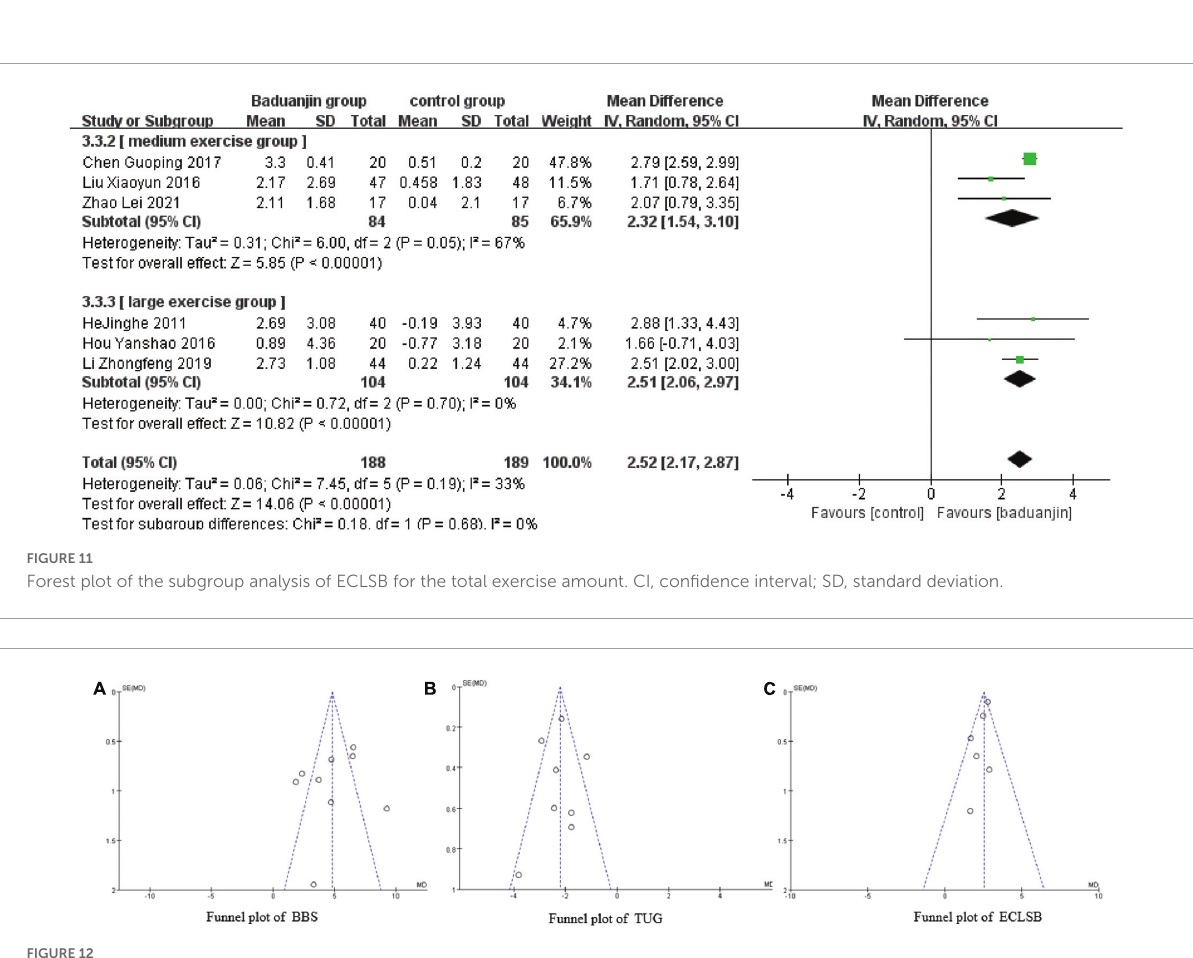
FIGURE12 Funnel plots of BBS (A) , TUG (B) and ECLSB (C) . SE, standard error; MD, mean